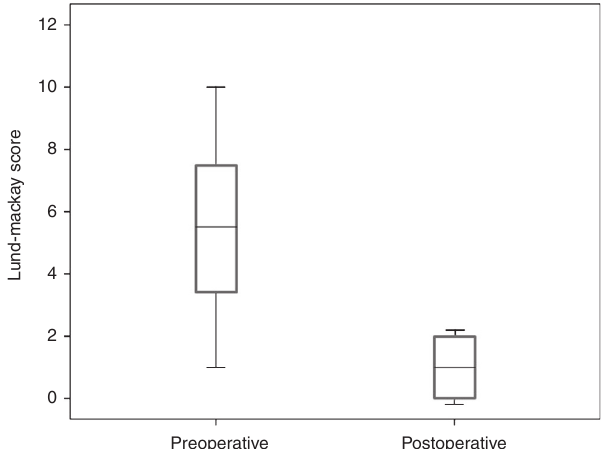
Lund---Mackay score of tomographic signs in the pre- and postoperative period. Lund---Mackay score in